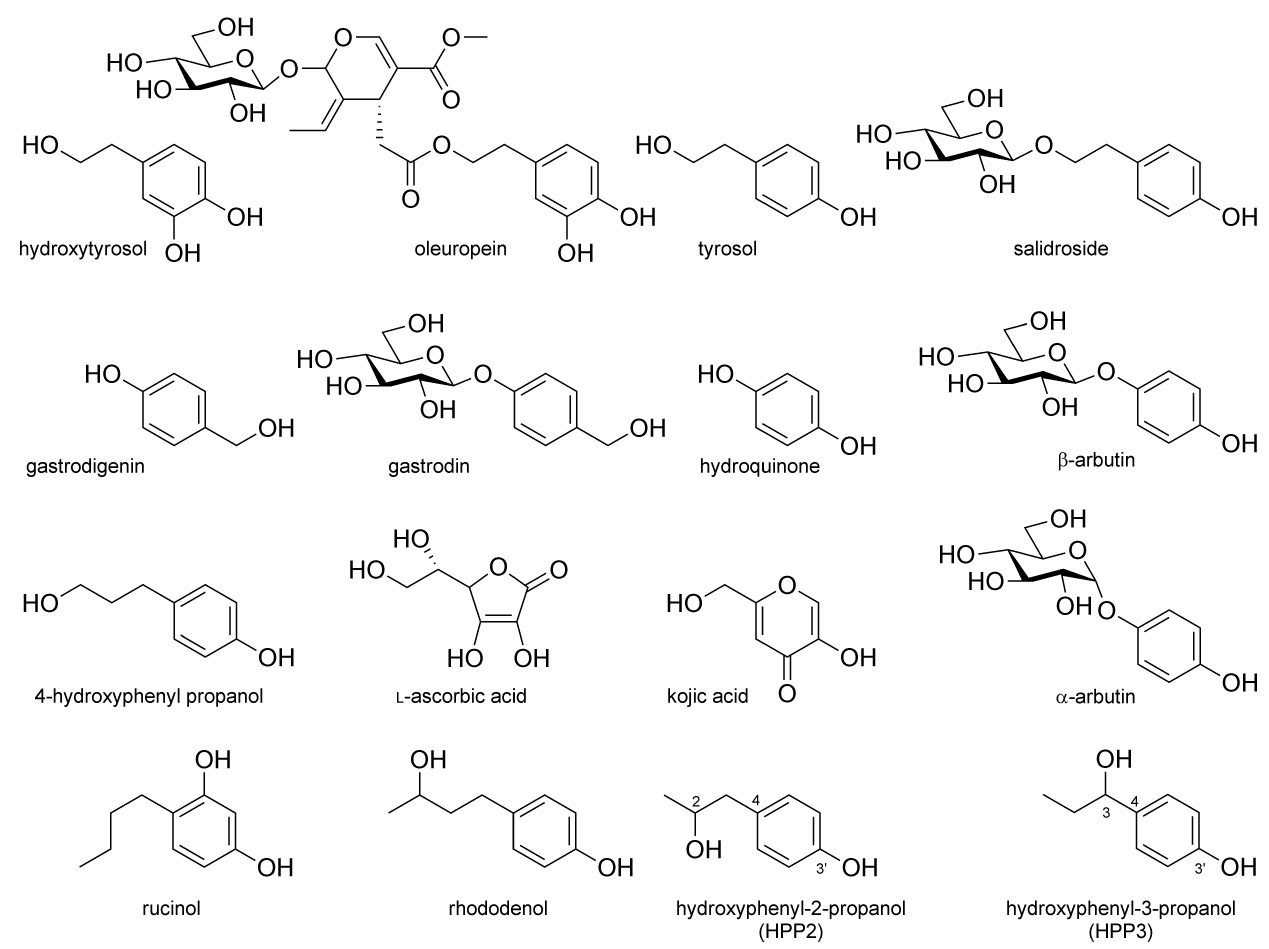
Figure 1. Chemical structures of simple phenolics, their glycosides and anti-melanogenic chemicals described in this study.